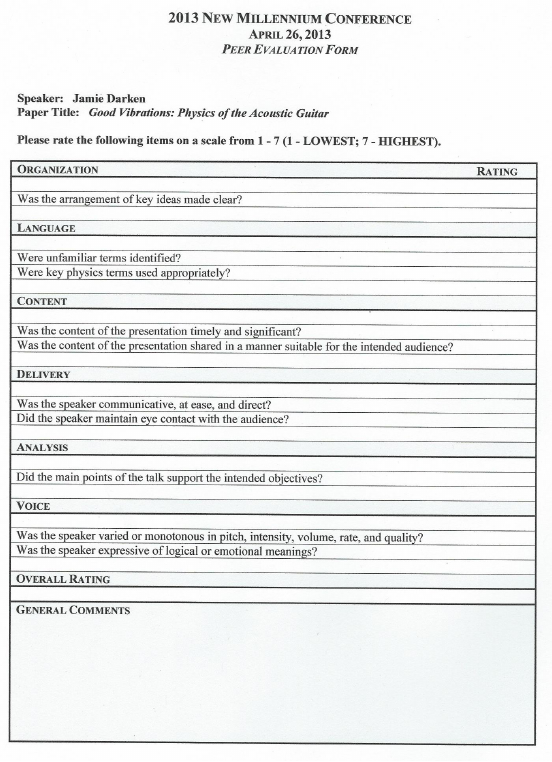
Figure 10. The presentation peer review